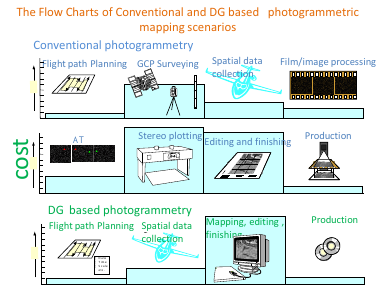
Figure 1 Procedures applied for conventional aerial